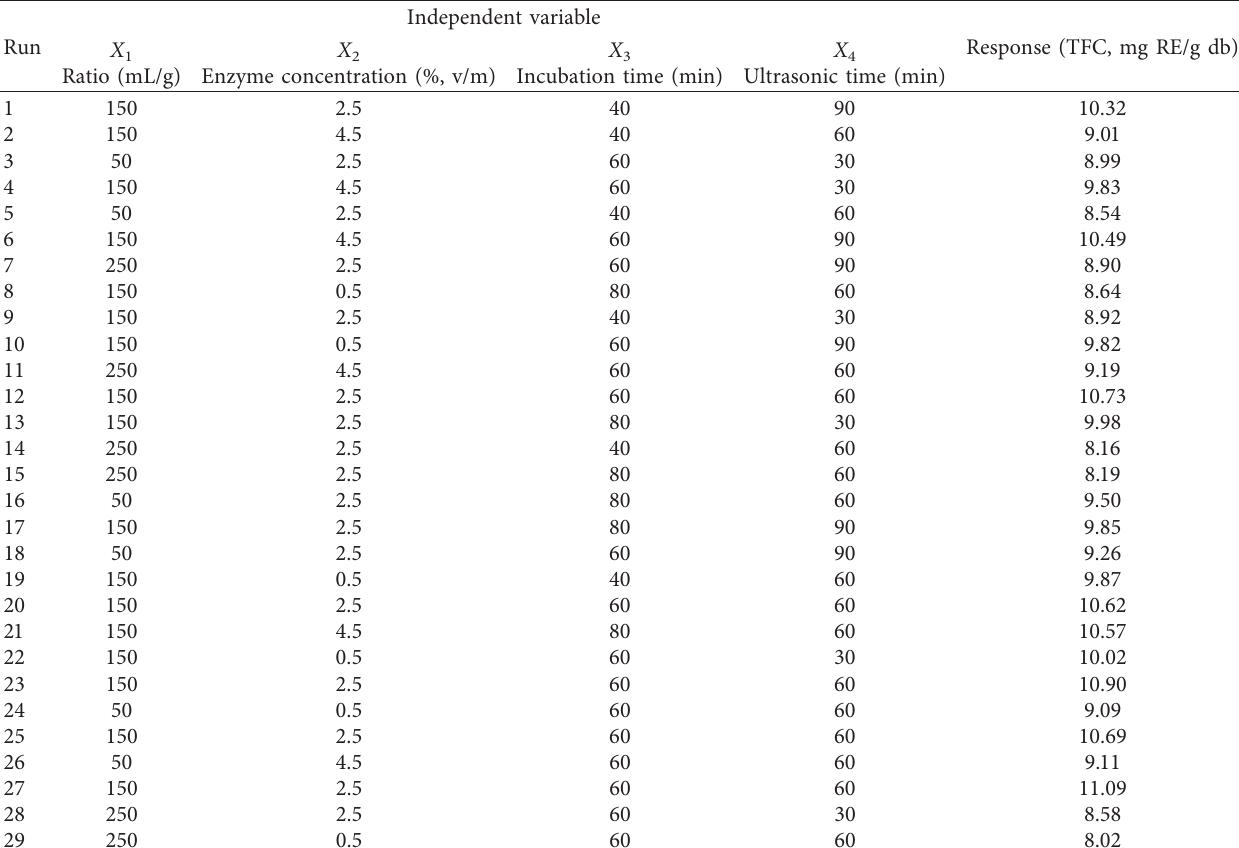
Table 2: Box–Behnken design and observed